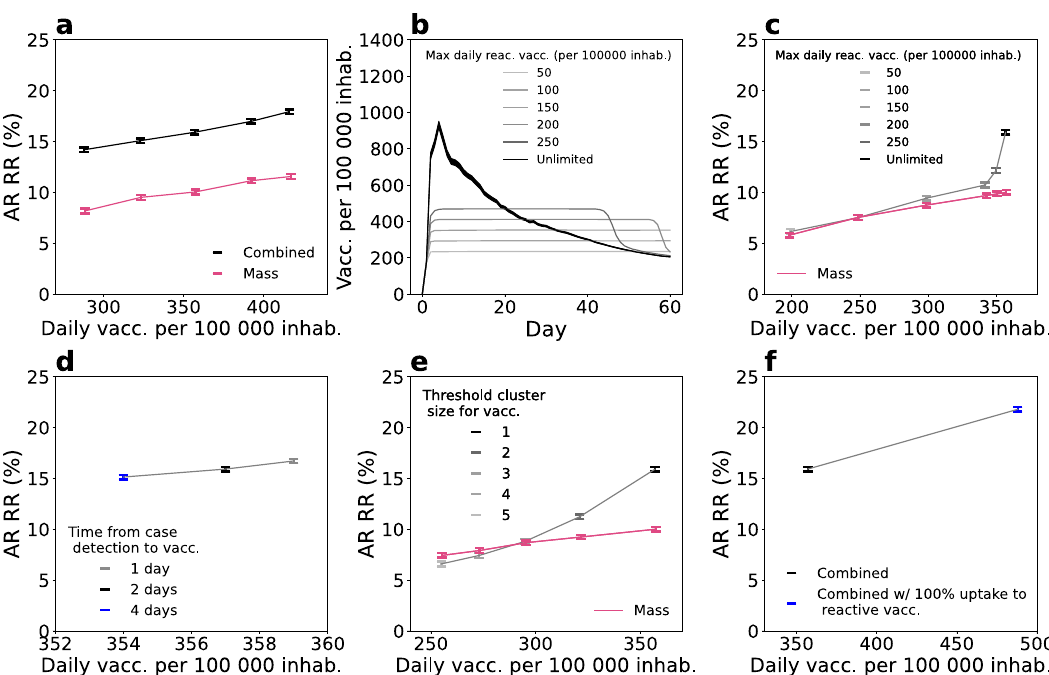
Fig. 3 Combined reactive and mass vaccination for managing sustained COVID-19 spread. a Relative reduction (RR) in the attack rate (AR) over the fi rst 2 months for the combined strategy (mass and reactive) and the mass strategy with the same number of fi rst-dose vaccinations as in the combined strategy during the period. RR is computed with respect to the reference scenario with initial vaccination only, as in Fig. 2. Combined strategy is obtained by running in parallel the mass strategy — from 50 to 250 daily vaccination rate per 100,000 inhabitants — and the reactive strategy. Number of doses displayed in the x -axis of the fi gure is the total number of doses used by the combined strategy, daily. Corresponding incidence curves are reported in Supplementary Fig. 8. b Number of fi rst-dose vaccinations deployed each day for the combined strategy with different daily vaccines ’ capacity limits. c , d , e AR RR for the combined strategy as a function of the average daily number of fi rst-dose vaccinations in the 2-months period. Symbols of different colours indicate: c different values of daily vaccines ’ capacity limit; d different time from case detection to vaccine deployment; e different threshold size for the cluster to trigger vaccination. In panel c and e the curve corresponding to mass vaccination only is also plotted for comparison. f Comparison between 100% and baseline vaccination uptake in case of reactive vaccination. Exception for the parameters indicated in the legend we assume in all panels baseline parameter values with intermediate vaccination coverage at the beginning — i.e. R = 1.6; VE S ,1 = 48%, VE SP ,1 = 53%, VE S ,2 = 70%, VE SP ,2 = 73%; initial immunity 32%; initial incidence 160 clinical cases weekly per 100,000 inhabitants; vaccinated at the beginning 90% and 40% for 60 + and <60, respectively. In panels a , c , d – f data are means over 2000 independent stochastic realisations and error bars are derived from the standard error of the mean. In panel b continuous lines are means over 2000 independent stochastic realisations and the shaded areas are the standard error of the mean (±2SEM) — only the standard error of the unlimited case is shown for clarity. The following abbreviations were used in the Fig.: vacc. for vaccines, inhab. for inhabitants, reac. for